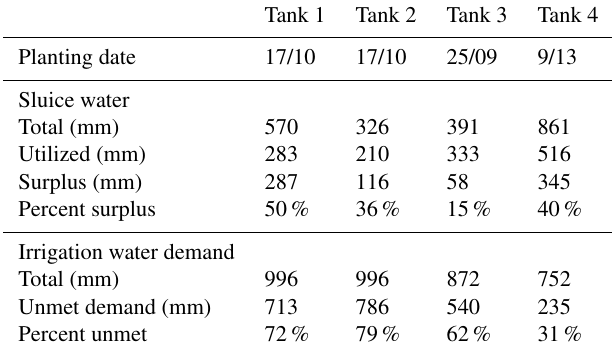
Table 5. Sluice outflows and irrigation water demand